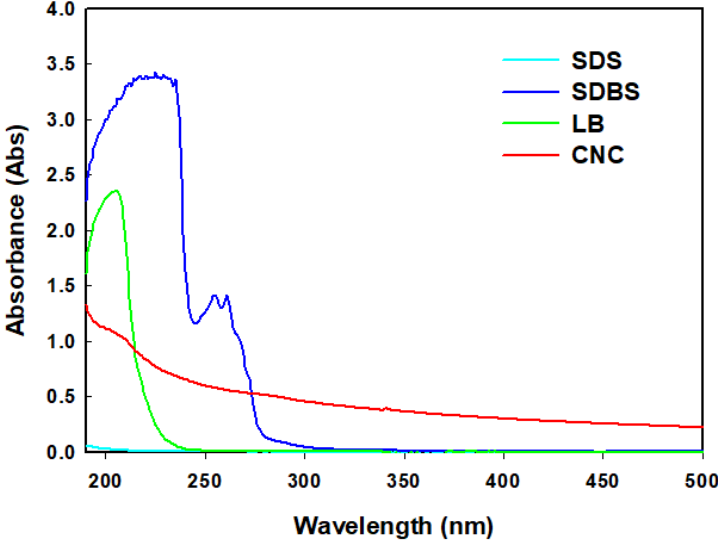
Figure 5. UV/VIS spectra of each surfactant.